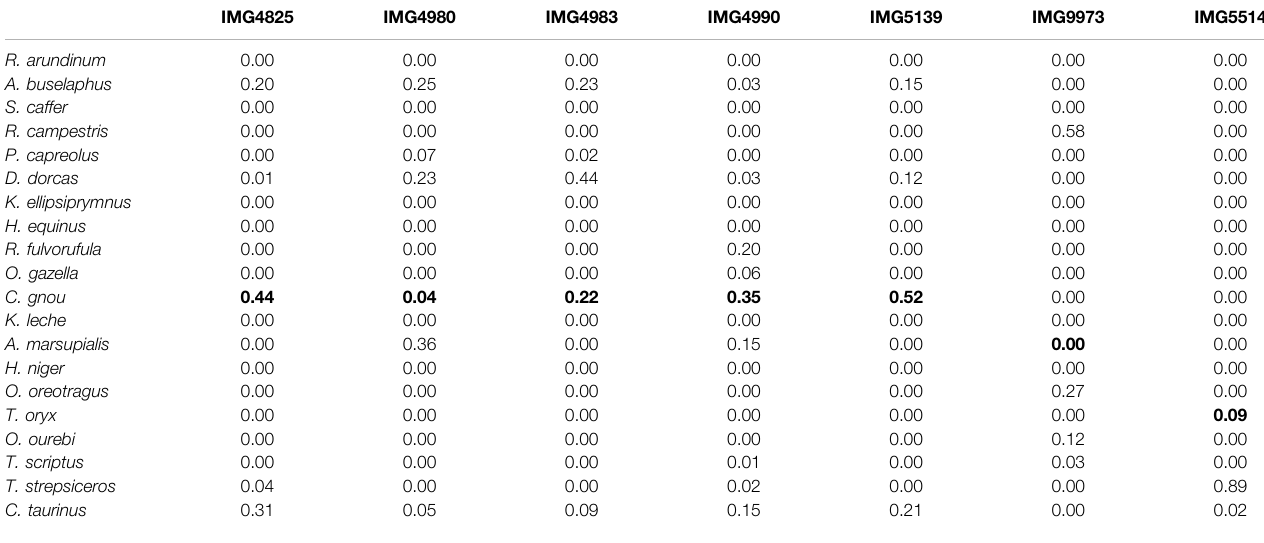
TABLE5| Realdata .Species-levelpredictedclassprobabilitieswithknn-impclassi fi erwith k n (cid:2) K (cid:2) M (cid:2) 10.Emboldenedvaluesindicatethe “ true ” classasobtainedfroman